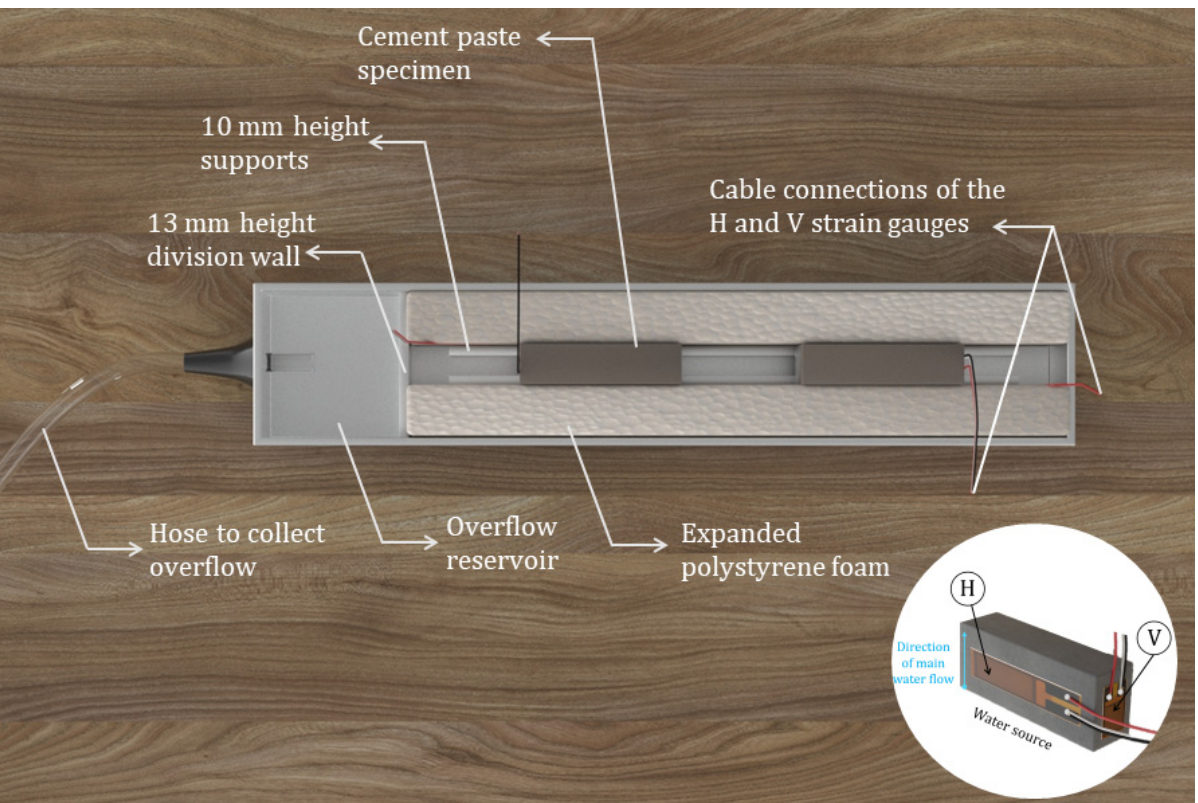
Figure 3. Set-up for capillary imbibition with continuous deformation monitoring.